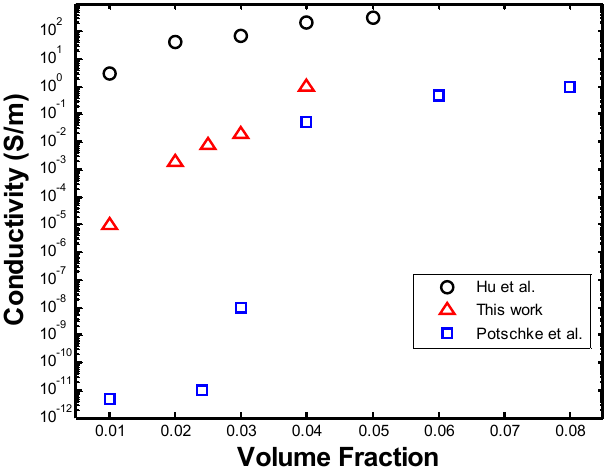
Figure 29. Comparison of conductivities to simulation and experimental data.